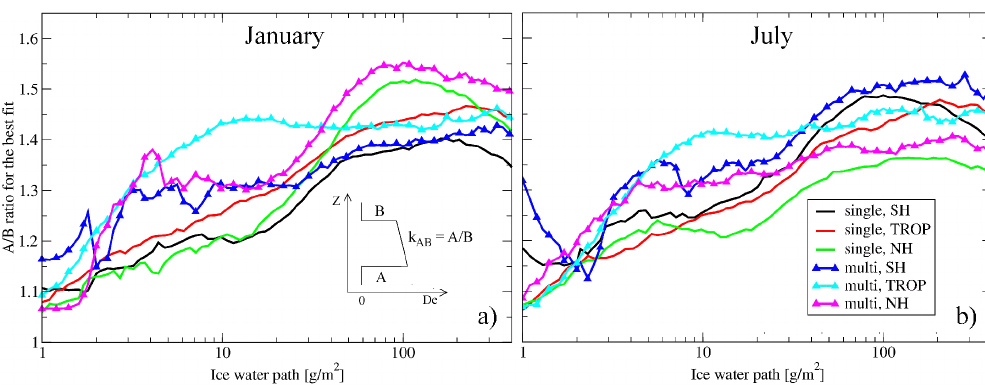
Figure 6. Values of k AB (ratio of the lower and upper edges of the trapezoid fitting De( z ) vertical profile) for single and multi-layer cloud scenes for three latitudinal zones for (a) January and (b) July. The legend is the same as in Fig. 4.